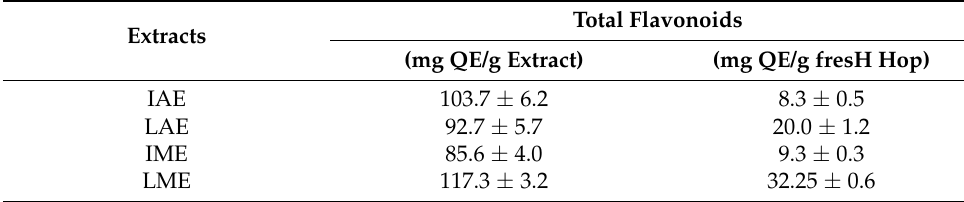
Table 6. Flavonoids of Chinook hops inflorescences and leaves.